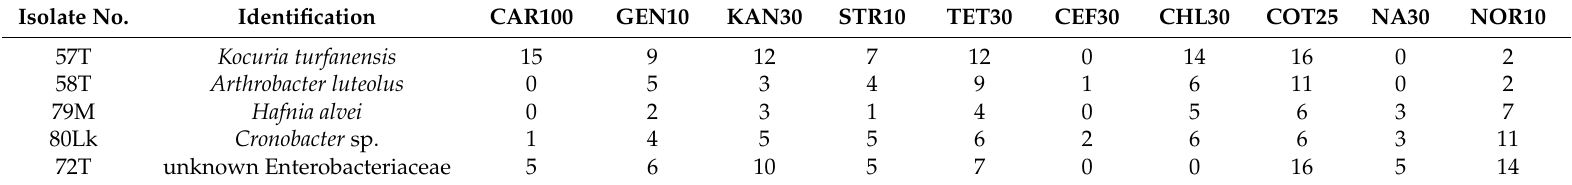
Table 3. Antibiotic resistance profiles of Actinobacteria and Proteobacteria isolates against ten different antibiotics. Isolate